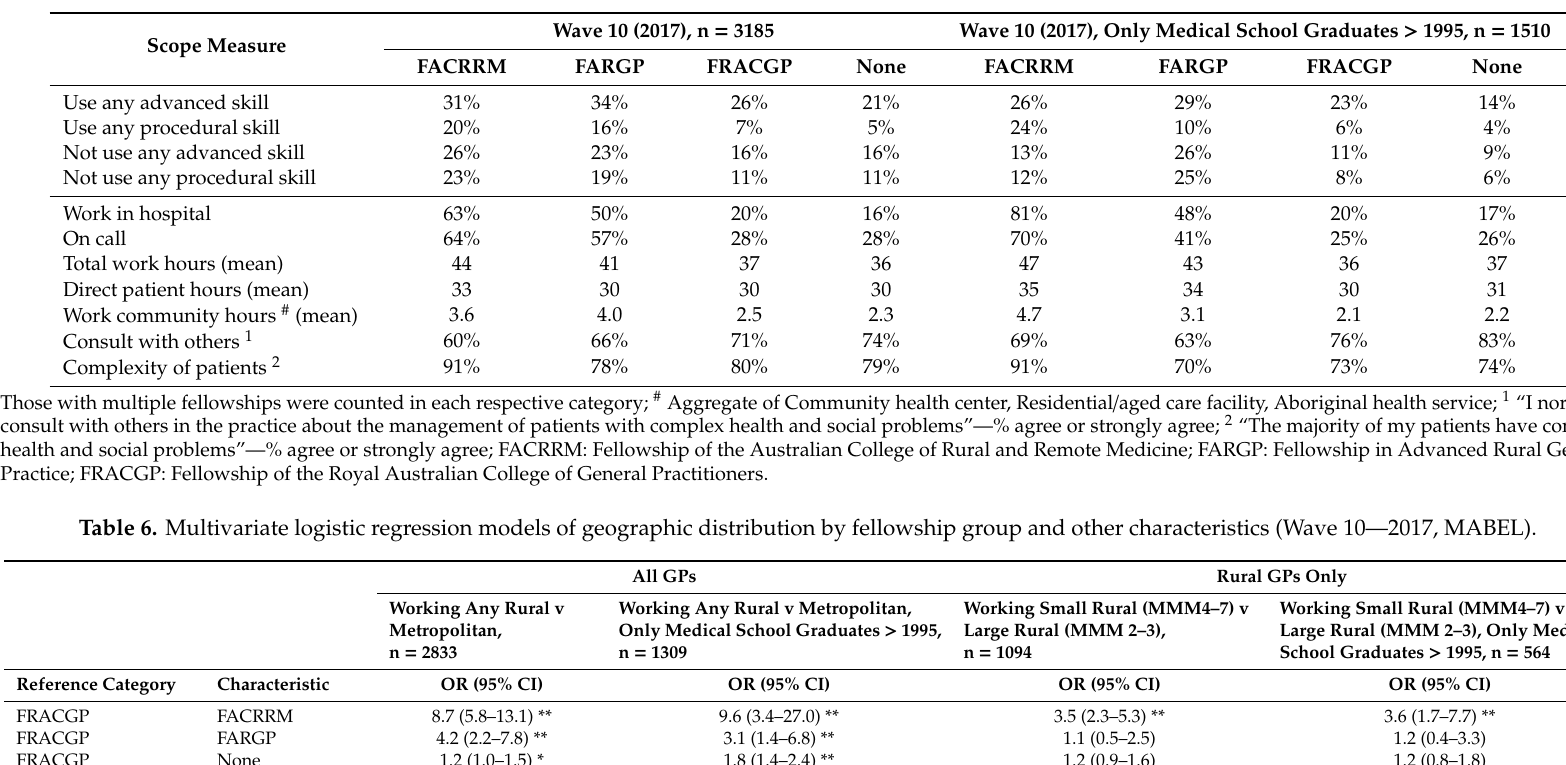
Table 5. Scope of practice of MABEL GP participants by fellowship group.